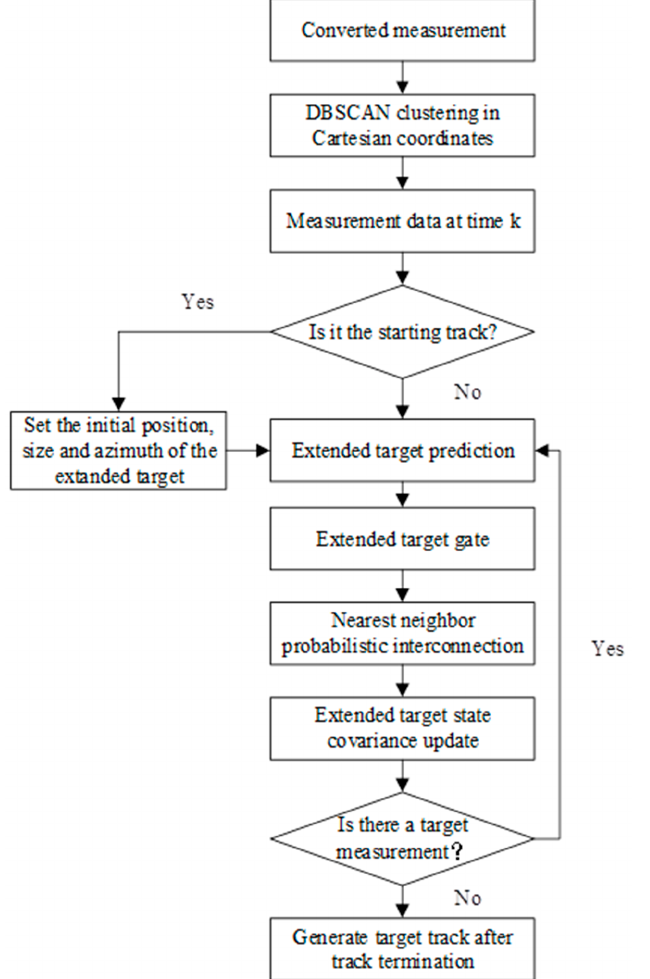
Figure 5. Flow chart of the CMKF-REMTT fusion algorithm.